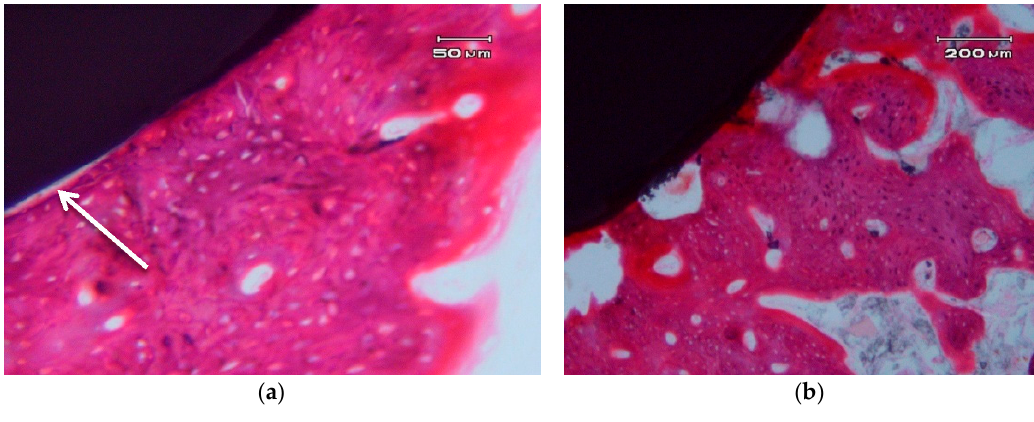
Figure 5. Transversal cross-sections of different nanocomposite ZCe-A implant-bone interfaces after eight weeks of healing. ( a ) and ( b ) show two different interfaces